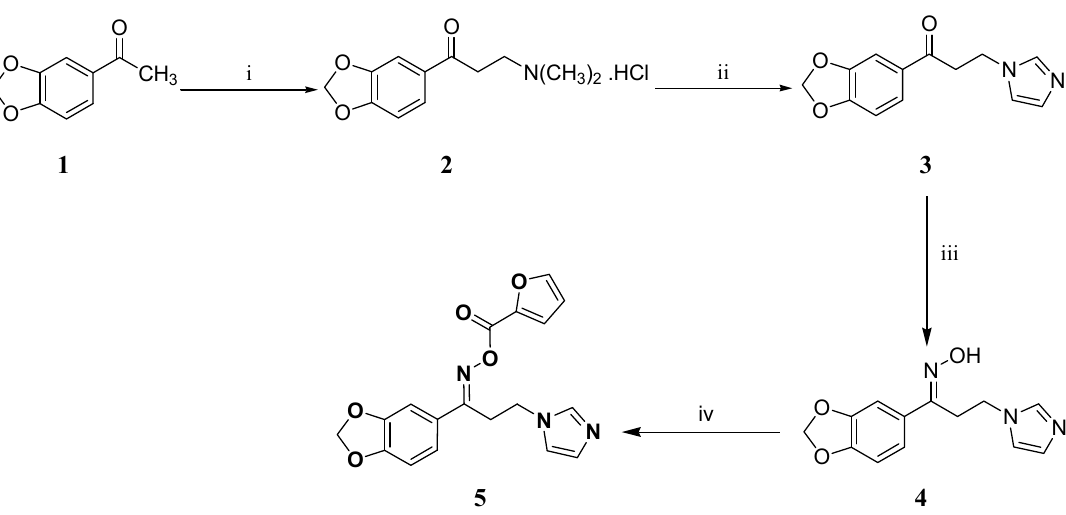
Scheme 1. Synthesis of the target oximino ester 5 . Reagents and conditions: (i) HN(CH 3 ) 2 .HCl, (CH 2 O) n , conc. HCl, ethanol, reflux, 2 h; (ii) Imidazole, water, reflux, 5 h; (iii) H 2 NOH.HCl, KOH, ethanol, reflux, 18h; (iv) N , N (cid:48) -Carbonyldiimidazole, furan-2-carboxylic acid, THF, rt, 18h.